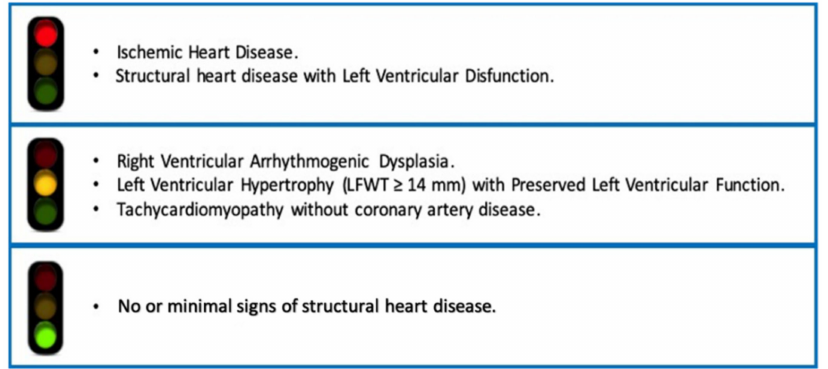
Figure 1. Current evidence on the use of flecainide. Structural heart disease is any abnormality, or defect, of the heart muscle or the heart